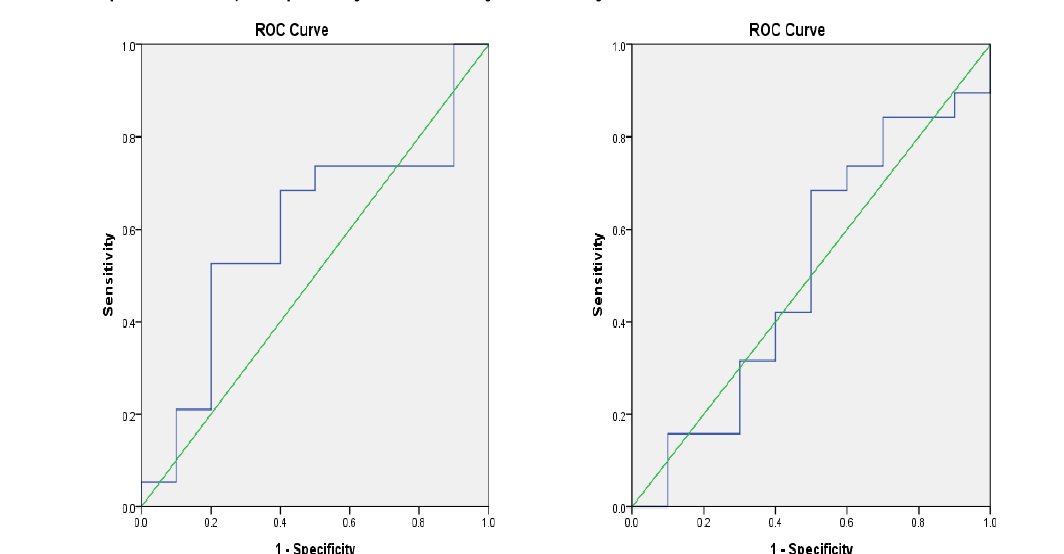
Figs. 3a. Comparative of Sensitivity and Specificity of the Family/taxa to predict T2DM, (A) Specificity and Sensitivity of the Paraprevotellaceae to predict T2DM, (B) Specificity and Sensitivity of the Enterobacteriaceae to predict T2DM, (C) Specificity and Sensitivity of the Bacteriodaceae to predict T2DM, (D) Specificity and Sensitivity of the Porhyromonadaceaeee for the Prediction of